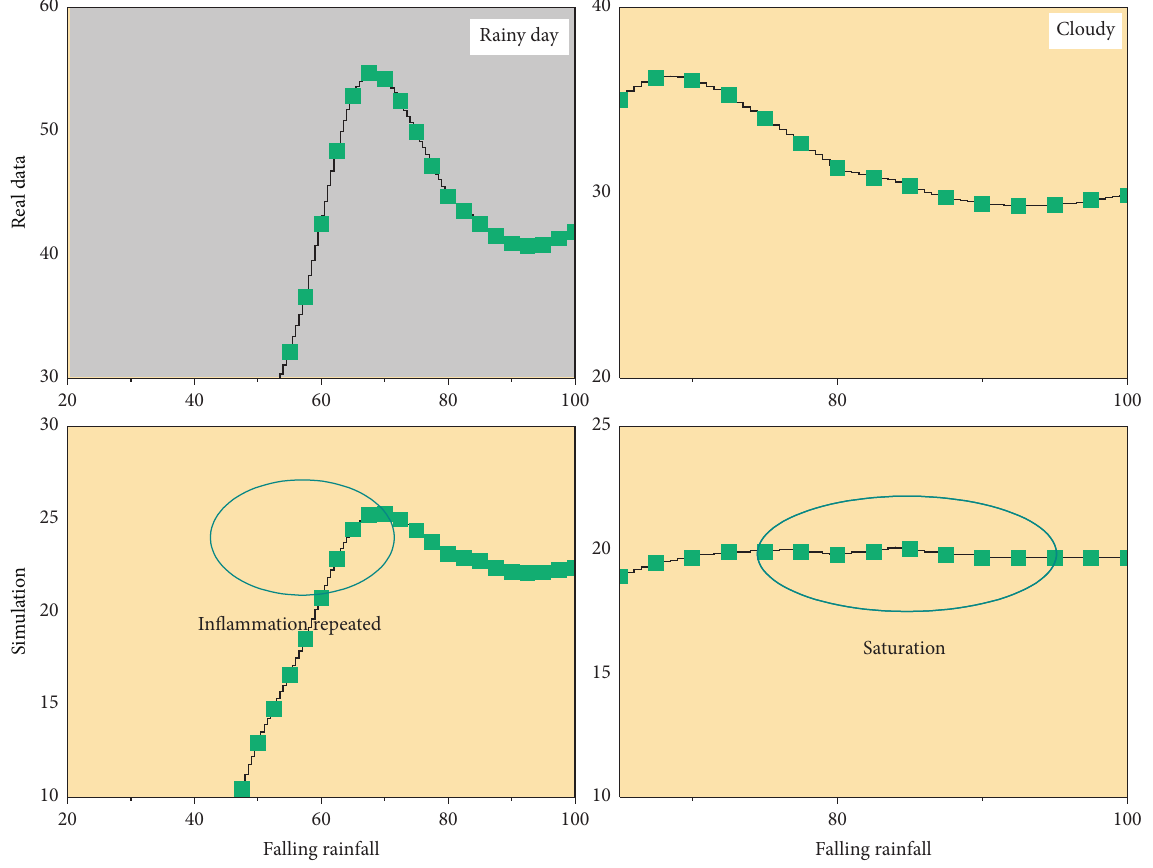
Figure 6: Monthly simulation results.